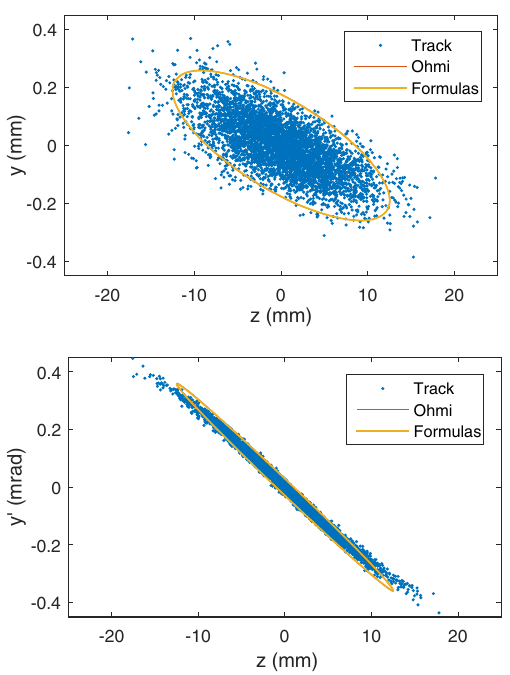
FIG. 2. The projection of equilibrium particle distribution (blue dots) at 13S onto the y - z plane (top) and y 0 - z plane (bottom) are compared to ellipses from numeric Ohmi envelope calculation (Ohmi) and calculations with Eqs. (80) and (81) and Eqs. (70) and (77) (Formulas). The ellipses cover 6 σ of the Gaussian distribu- tion for the corresponding projected